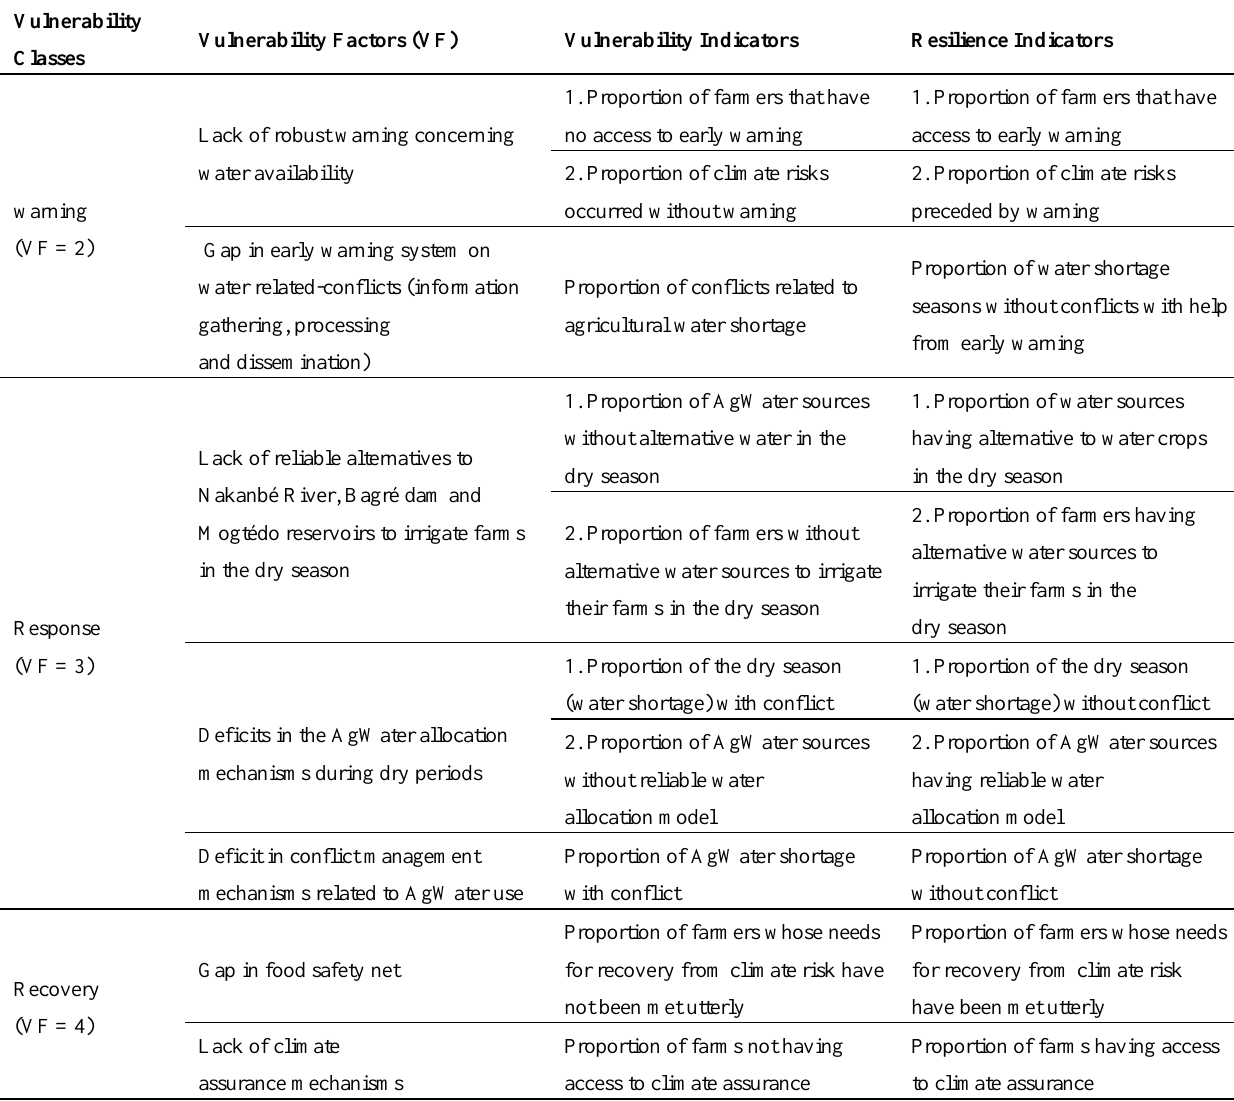
Table 3. AgWater resilience indicators matrix under climate